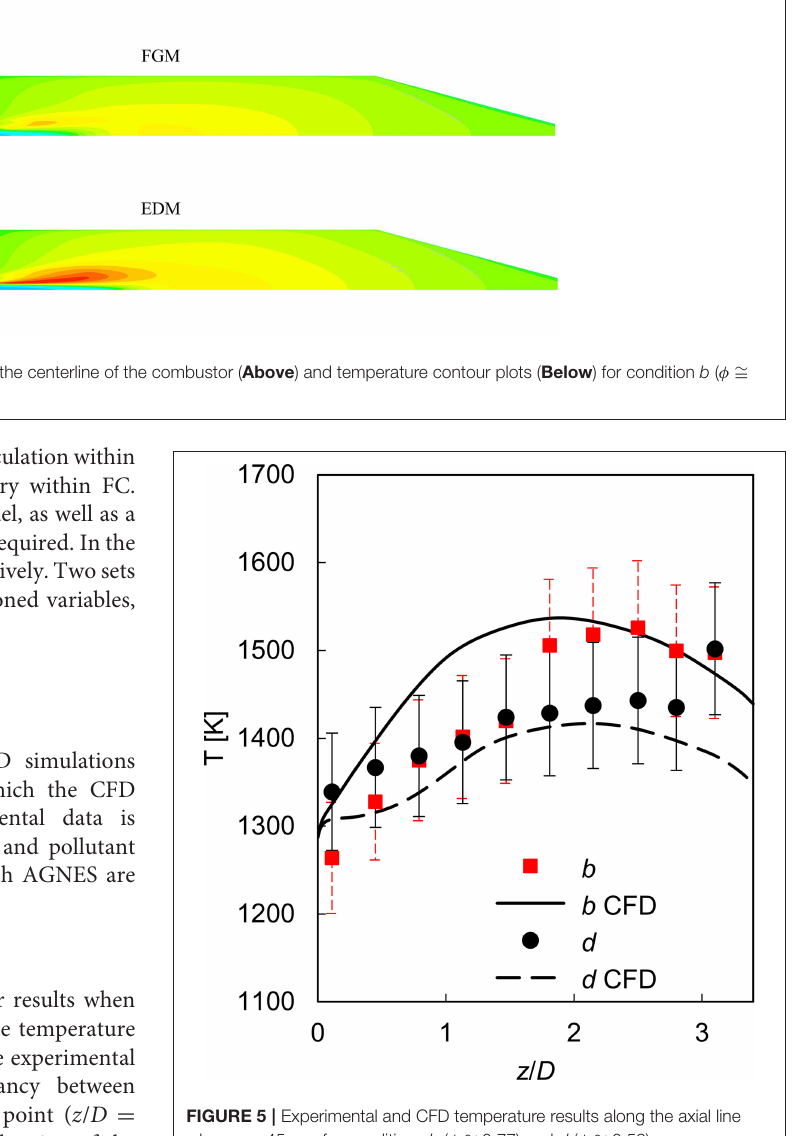
et al. (2011) to be around 5% (as is shown by the error bars in Figure 4